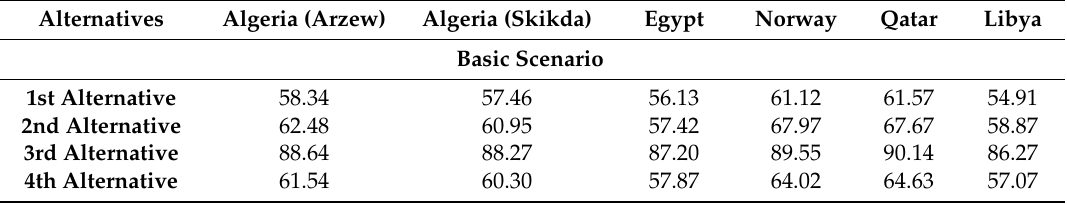
Table 12. The results obtained from the Additive Value Model for all the